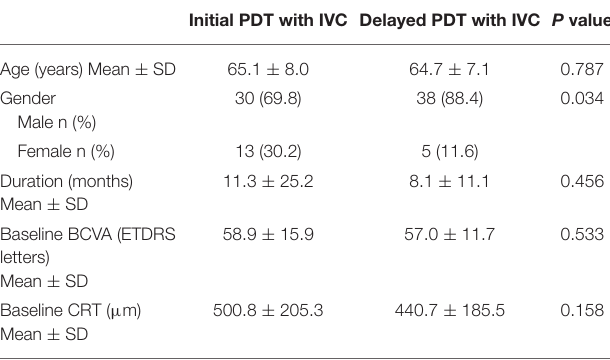
TABLE 1 | Baseline demographics and ocular disease characteristics (randomized